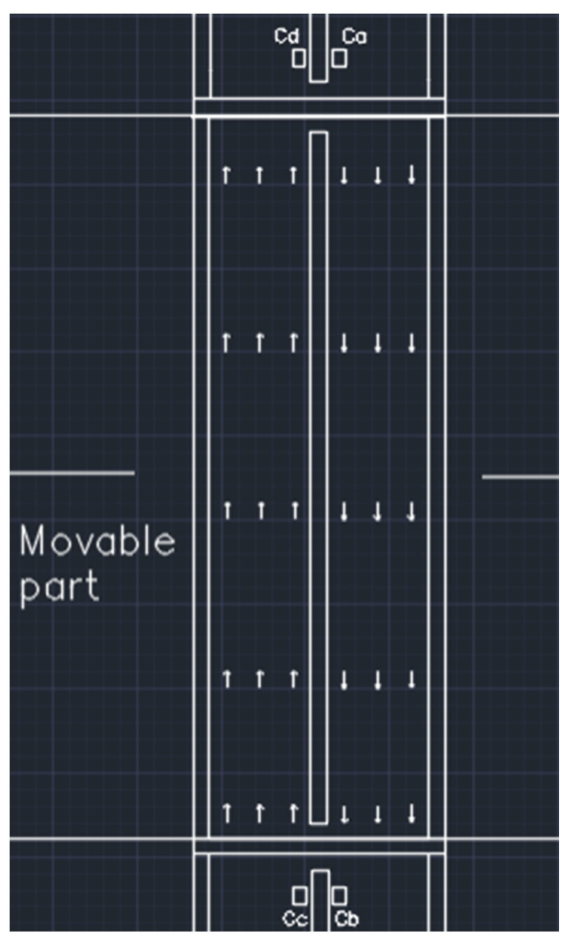
Figure 4. The camera setups for bridge traffic control